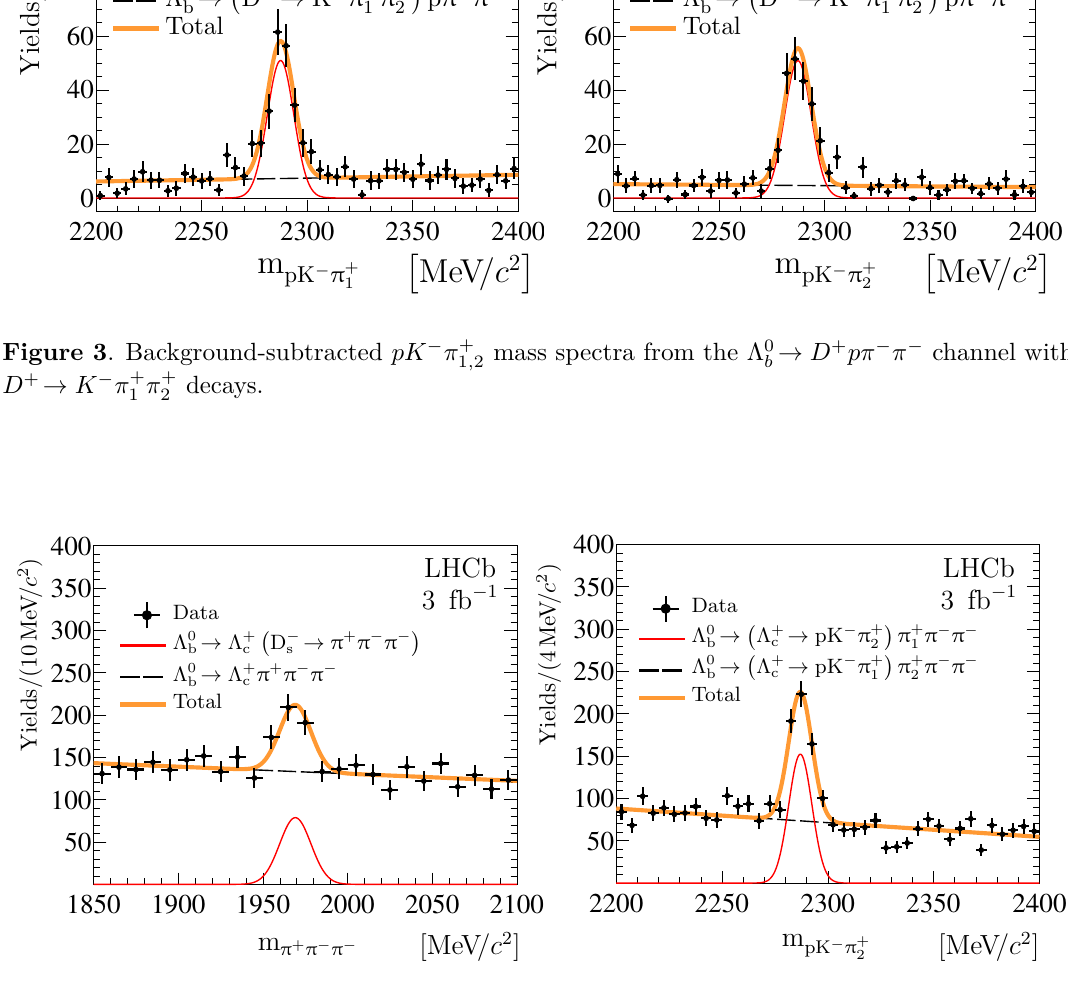
→ Λ + π + π − π − decays c b (cid:0) Λ + (cid:1) → → pK − π + π + π − π − decays. The results of c 1 2 b